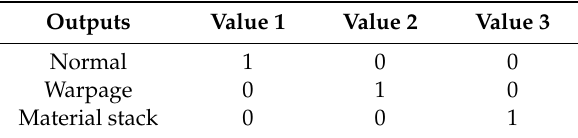
Table 5. The outputs format of BPNN model.